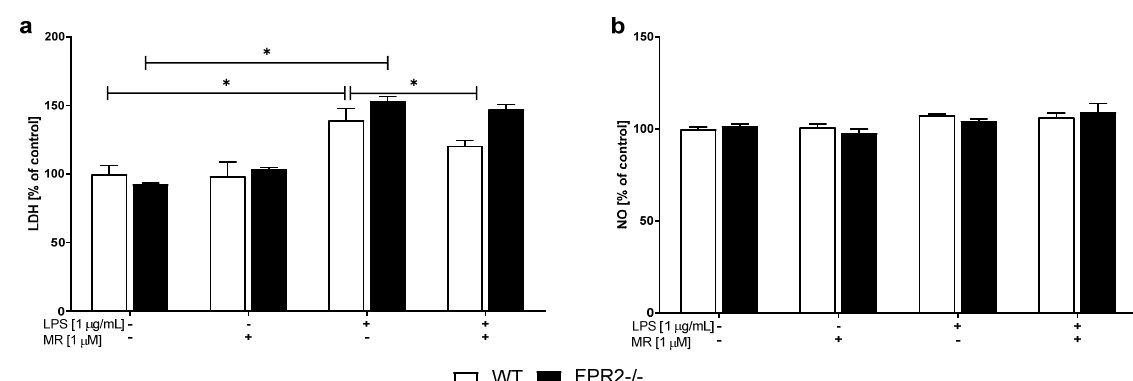
Figure 2. The effects of LPS and the compound MR-39 on cell death ( a ; LDH) and nitric oxide ( b ; NO) release in organotypic hippocampal cultures (OHCs) obtained from the offspring of wild-type (WT) and FPR2 − / − (KO) mice. OHCs were pretreated with MR-39 and then stimulated with lipopolysaccharide (LPS; 1 µ g/mL) for 24 h. Control cultures were treated with the appropriate vehicle. NO release was measured using the Griess reaction. The data are presented as the mean percentages ± SEM of the control (vehicle-treated WT OHCs) from three independent experiments. The results were statistically evaluated using a two-way analysis of variance (ANOVA) with the Duncan post hoc test to assess the differences between the treatment groups. Significant differences are indicated by * p < 0.05. LDH—lactate dehydrogenase; NO—nitric oxide. +—with LPS or MR treatment; -—without LPS or MR treatment.